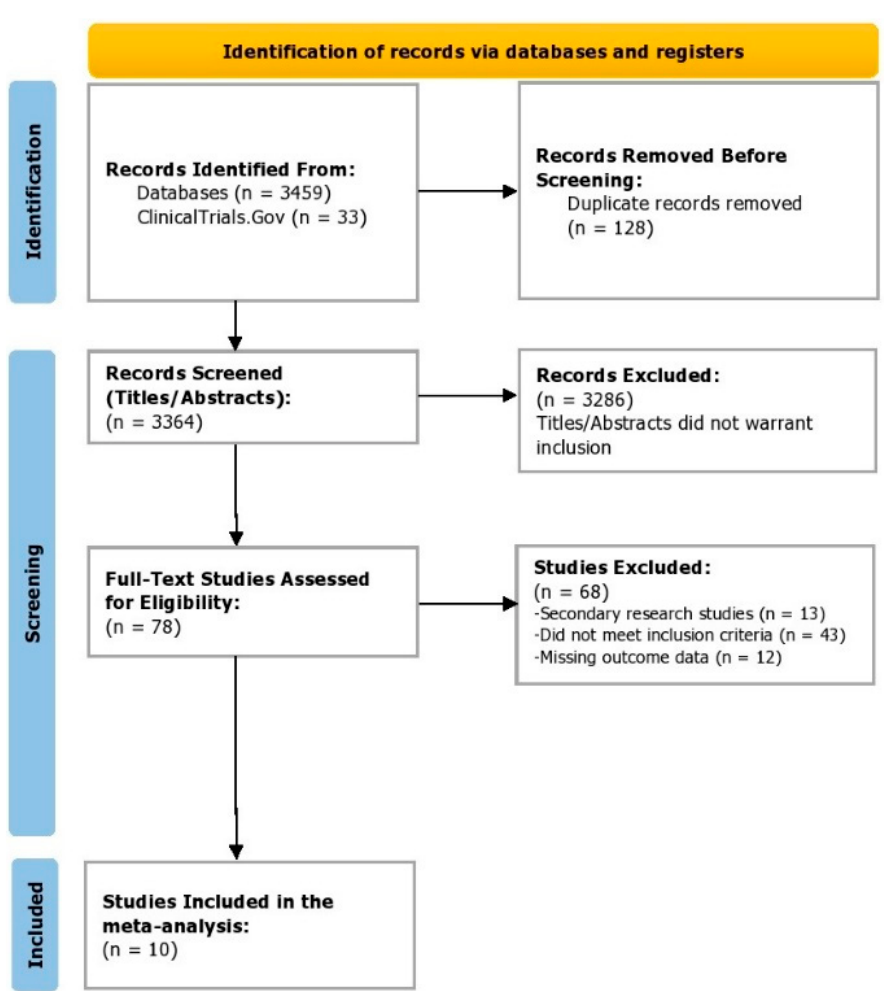
Figure 1. PRISMA flowchart depicting the study selection process.